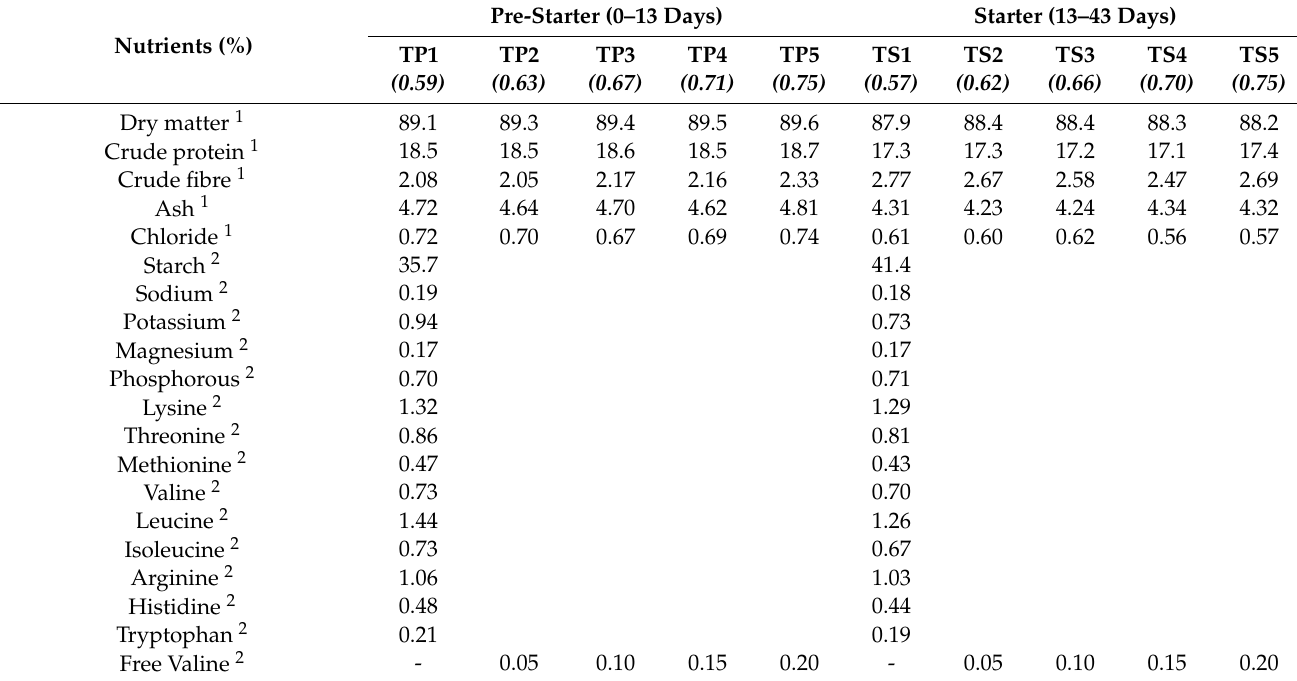
Table 3. Concentration of analyzed nutrients during pre-starter and starter